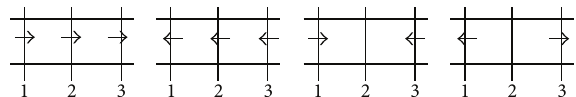
Figure 2: Illustration of the suspended sediment on grid and network domains. Figure 3: The four types of the flow at a single river channel. The types are as follows: downflow, upflow, faced-flow, and depart-flow, from the left to the